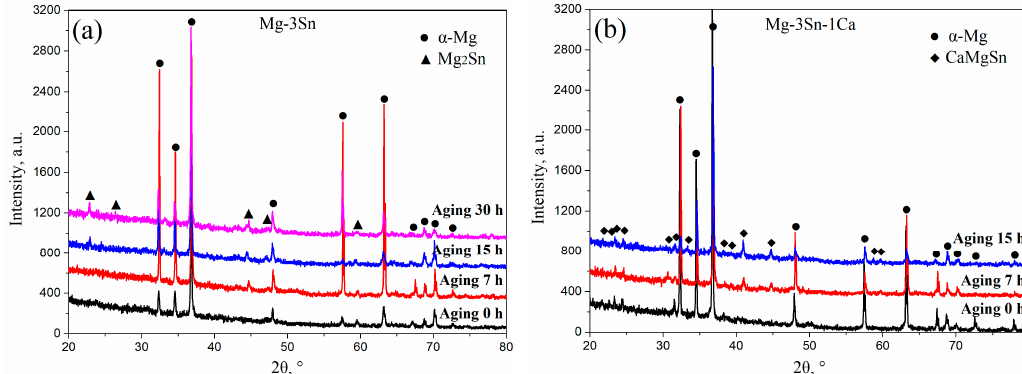
Figure 3. XRD patterns of aged Mg-3Sn ( a ) and Mg-3Sn-1Ca ( b ) alloys with different aging times at 513 K.